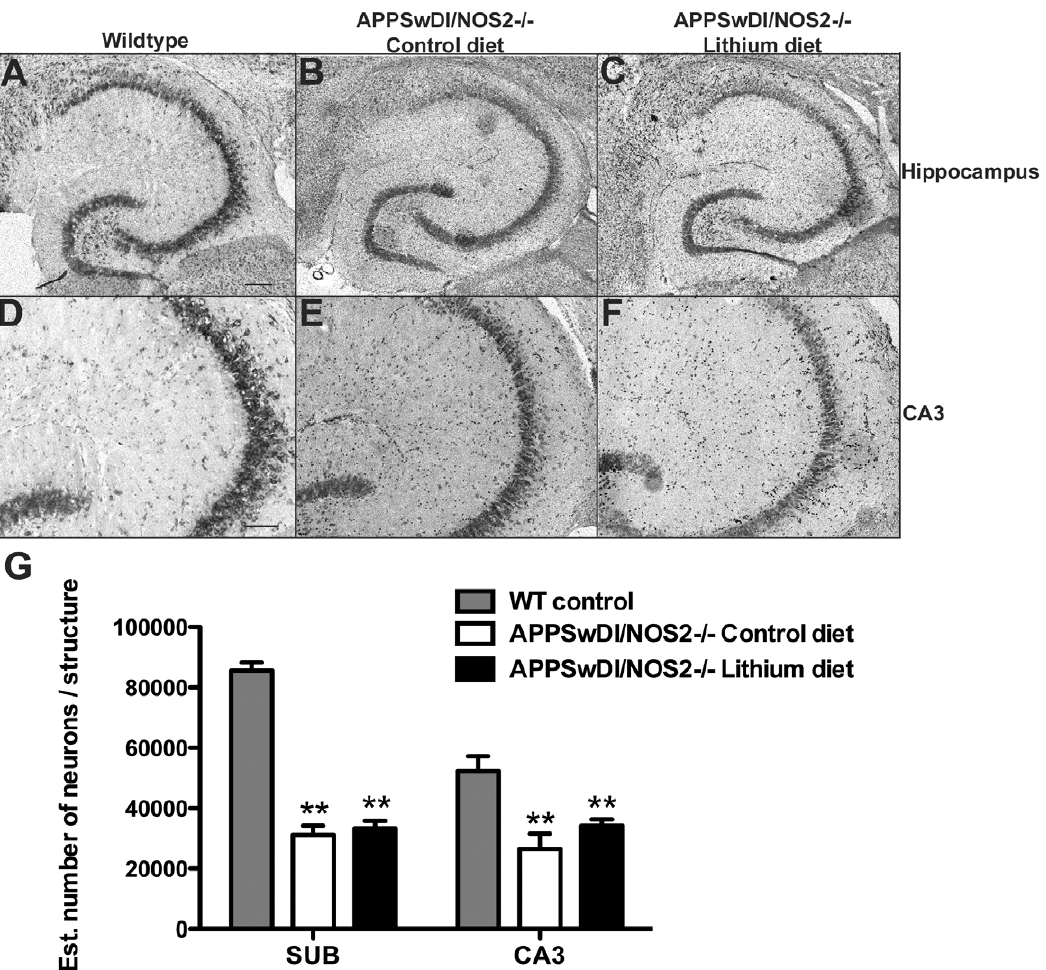
Figure 4. Lithium treatment does not alter neuronal loss in the APPSwDI/NOS2 2 / 2 mice. Panels A–F show Nissl staining for wildtype (A and D), APPSwDI/NOS2 2 / 2 mice receiving control diet (B and E) and APPSwDI/NOS2 2 / 2 mice receiving lithium diet (C and F). Panels A–C show the whole hippocampus at 40 6 magnification (scale bar in A for A–C=120 m m). Panels D–F show the CA3 region of the hippocampus at 100 6 magnification (scale bar in D for D–F=50 m m). Panel G shows stereological counts of neuron number in the subiculum and CA3 of wildtype mice and APPSwDI/NOS2 2 / 2 mice receiving either control diet or lithium diet. ** indicates P , 0.01 compared to wildtype mice.